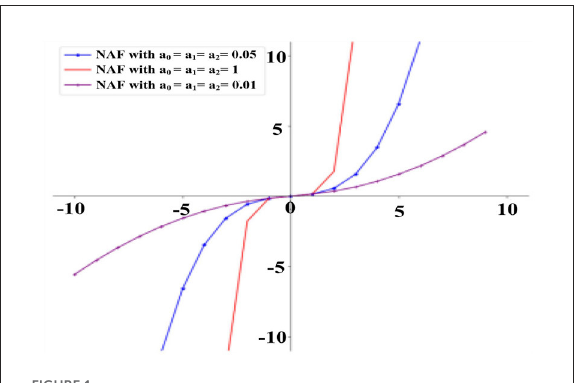
FIGURE1 NAF (1) with different parameters.